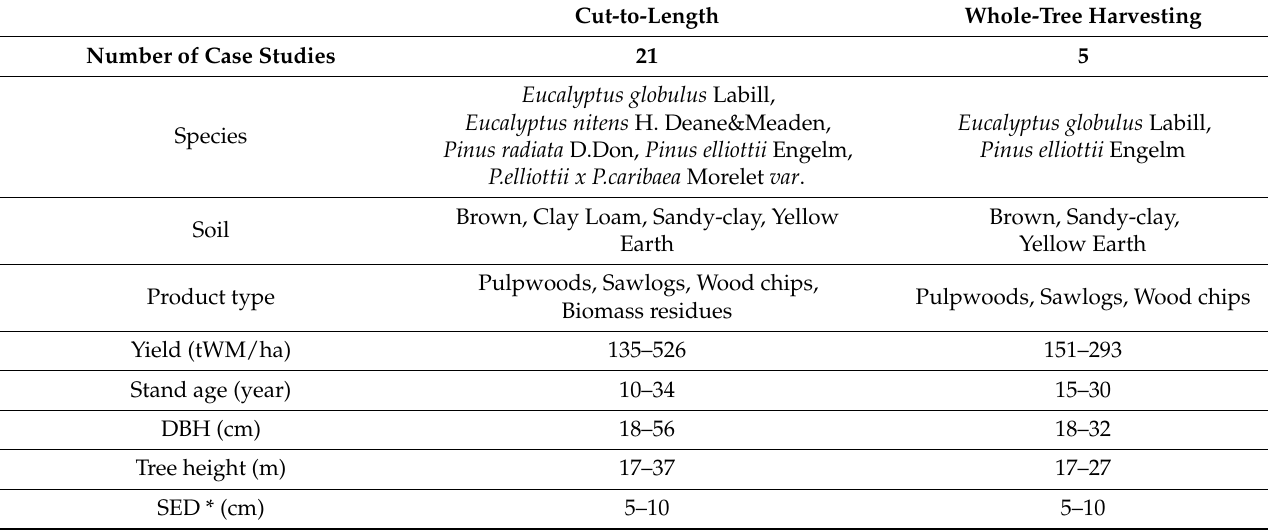
Table 1. Characteristics of the study sites. Cut-to-Length Whole-Tree